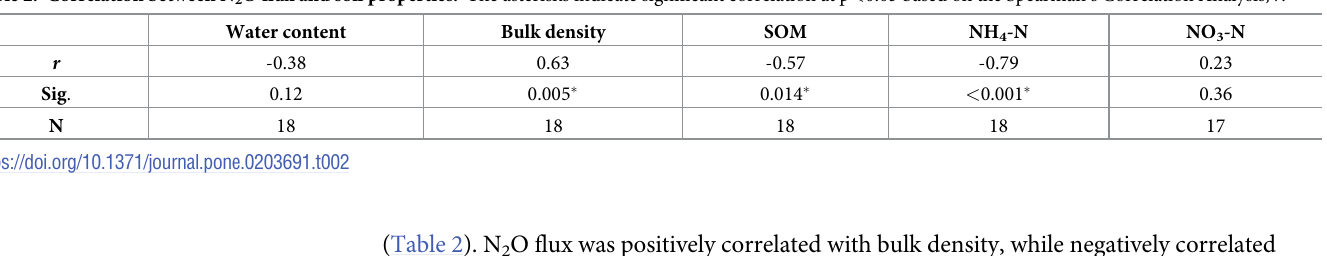
(Table 2). N O flux was positively correlated with bulk density, while negatively correlated 2 with SOM and NH -N content. 4